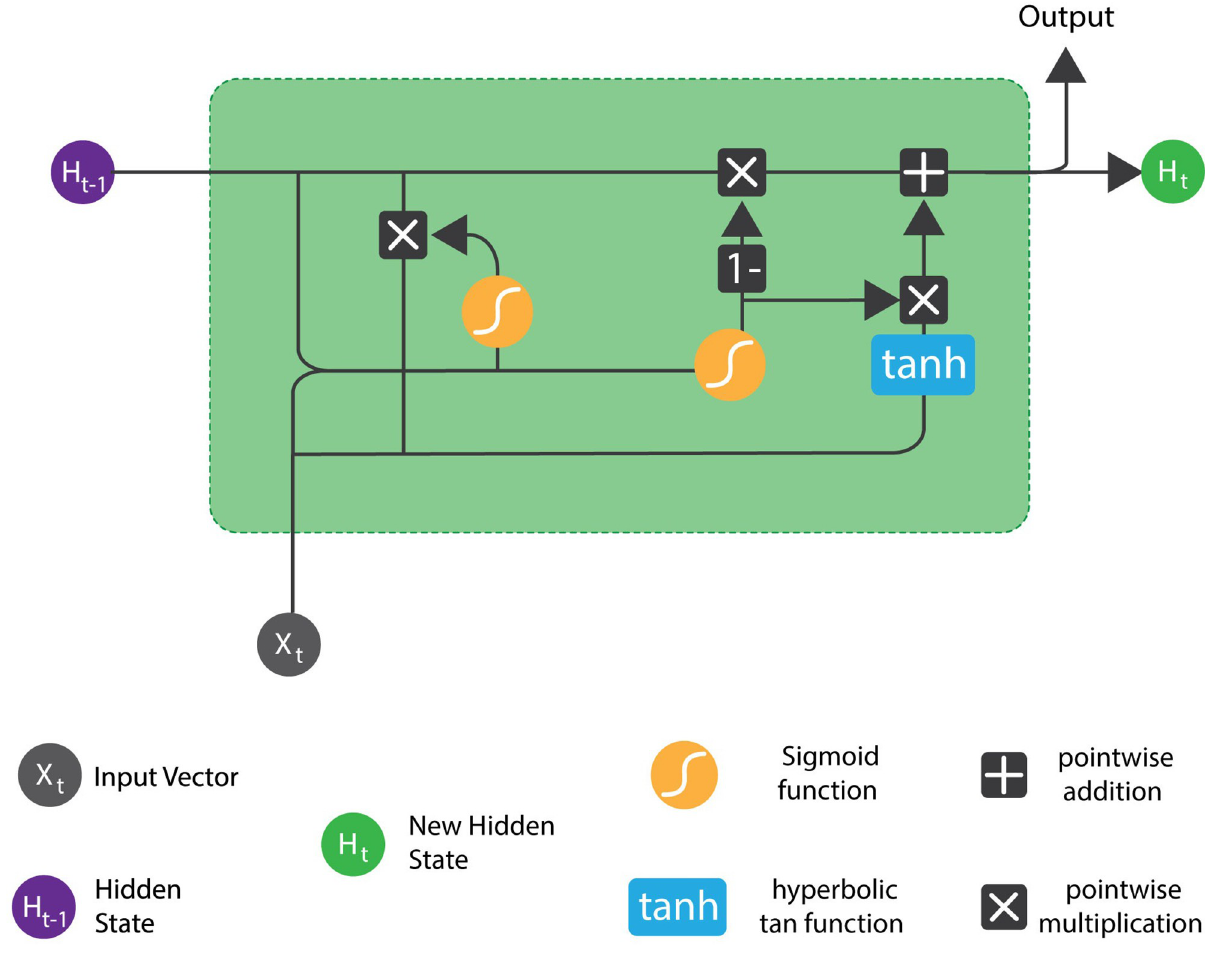
Fig 1. Structure of a GRU cell